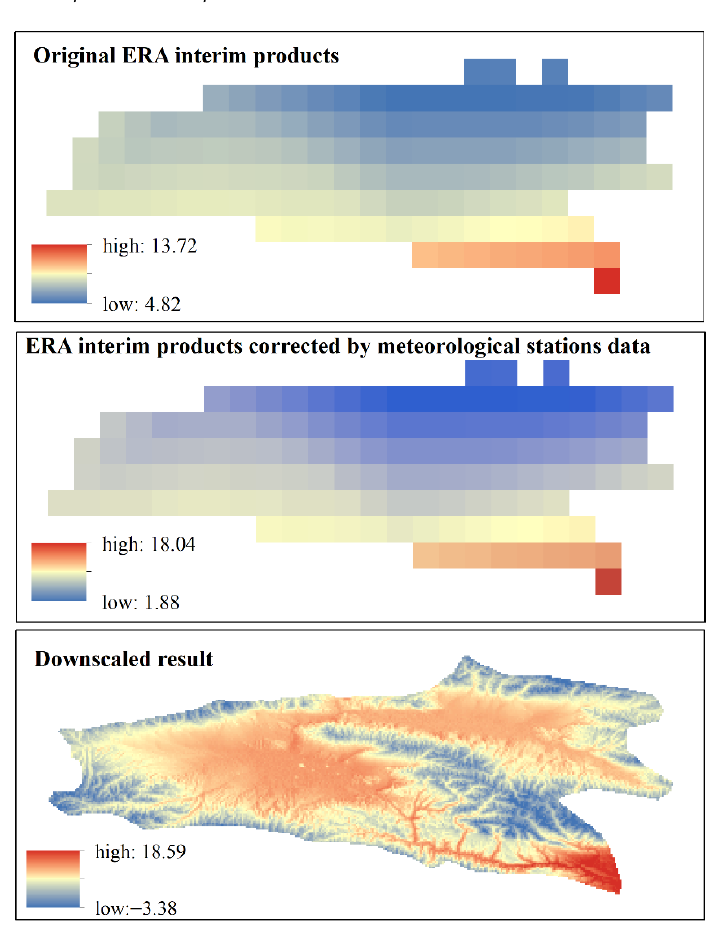
Figure A3. Downscaling of temperature at 2 m product in KDB.